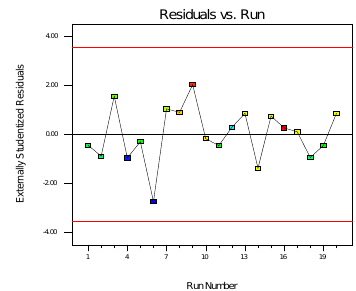
Design-Expert® Software Ra Color points by value of Ra: